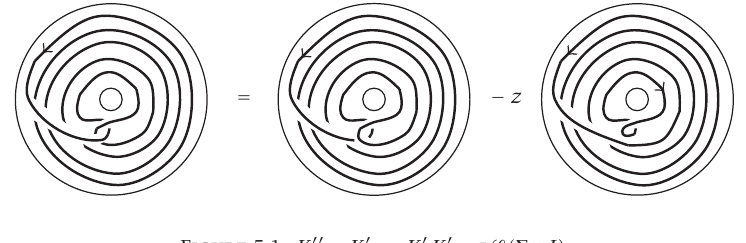
Figure 5.1 . K (cid:10)(cid:10)